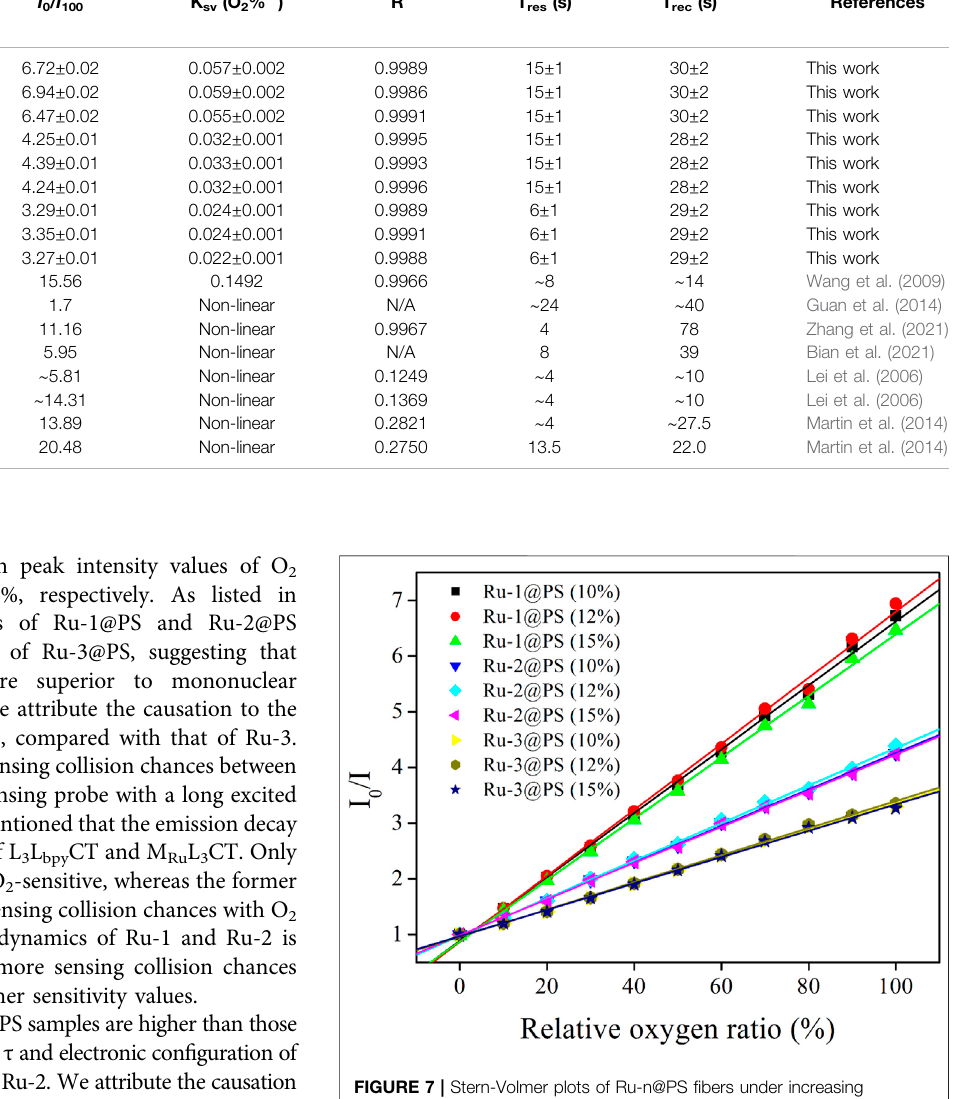
TABLE 2 | Sensing and fi tting parameters of Ru(II)@PS fi bers. Dopant, concentration